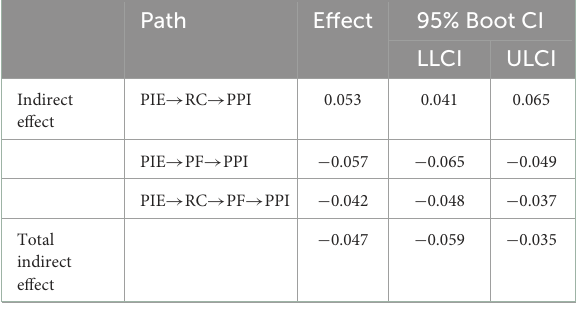
TABLE 5 Results of mediating effect